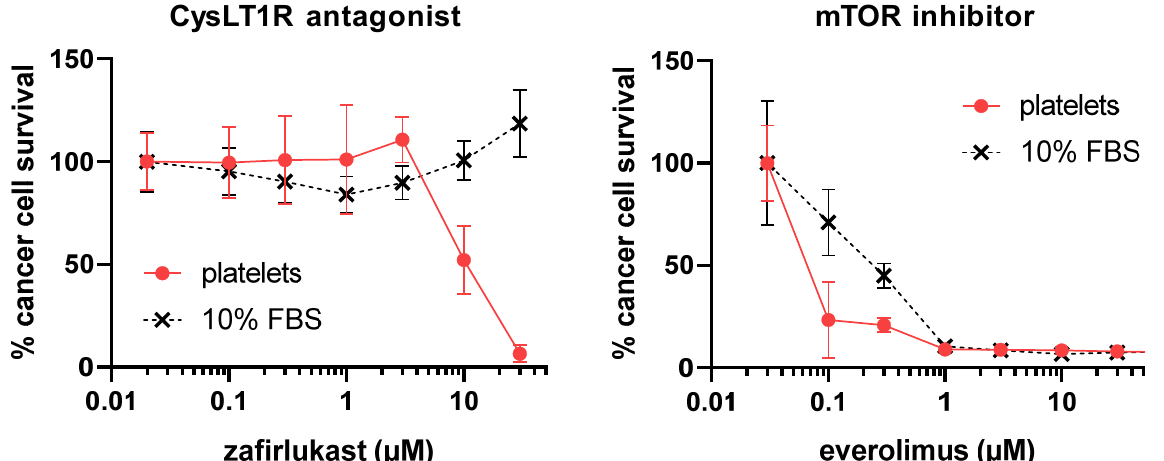
Figure 1. High-throughput screening identifies CysLT1R antagonists as specific inhibitors of human platelet-induced survival of human breast cancer cells. ( A ) A high-throughput screening using the Prestwick chemical library of 1280 FDA-approved drugs has been developed to identify compounds that inhibit platelet protumoral functions. For this, MDA-B02-Luc breast cancer cells were cultured for 48 h with human platelets in serum-free media, or with media supplemented with 10% FBS. The survival of cancer cells was measured using a bioluminescence assay (BLI). The % ∆ activity (platelets vs. FBS) was calculated from the difference between the platelet activity inhibition and the FBS activity inhibition of the drug. ( B ) CysLT1R antagonist, montelukast, and zafirlukast showed a high specificity for the inhibition of platelet-induced cancer cell survival at 10 µ M (% ∆ activity). ( C ) Dose–response curve of the CysLT1R antagonist zafirlukast and the mTOR kinase inhibitor everolimus on platelet- and serum-induced cancer cell survival. Data is the mean ± SD and is representative of three independent experiments. Abbreviations: BLI = bioluminescence; FBS = fetal bovine serum.